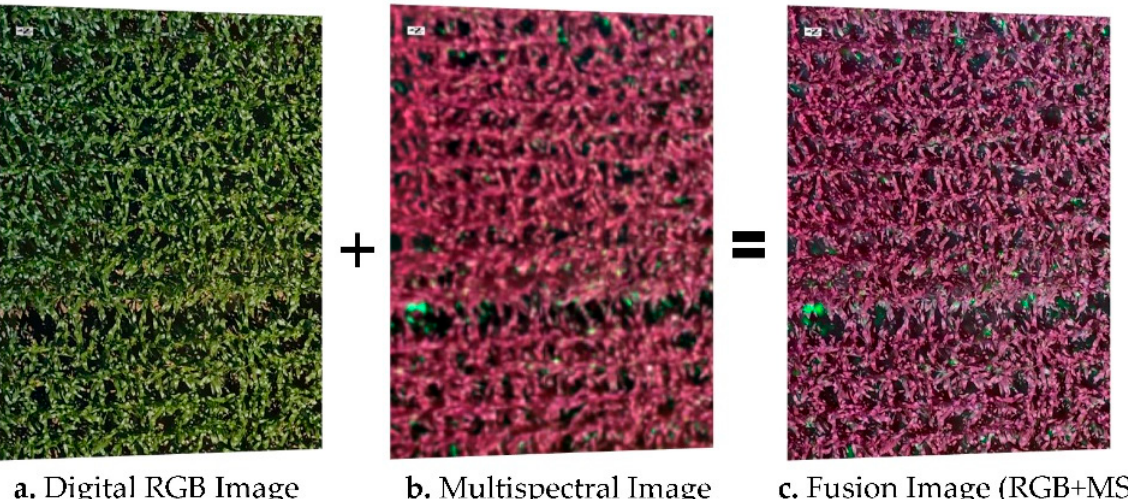
Figure 4. Image Fusion of GS.